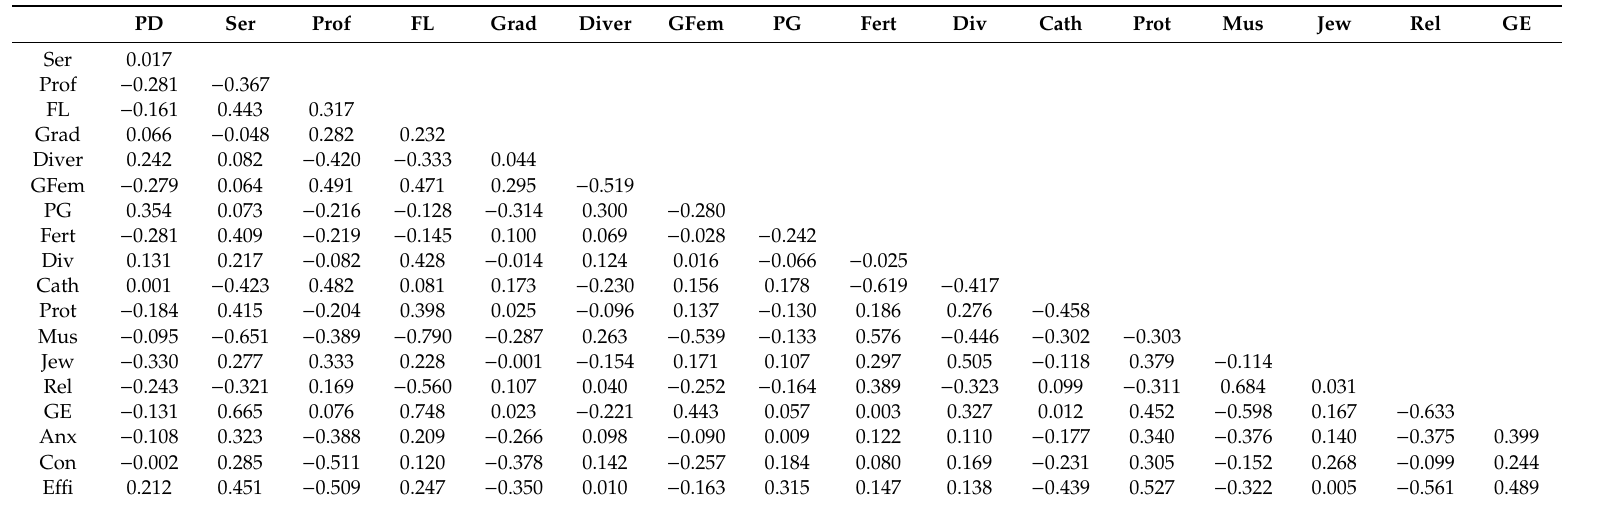
Table A4. Cross-correlation